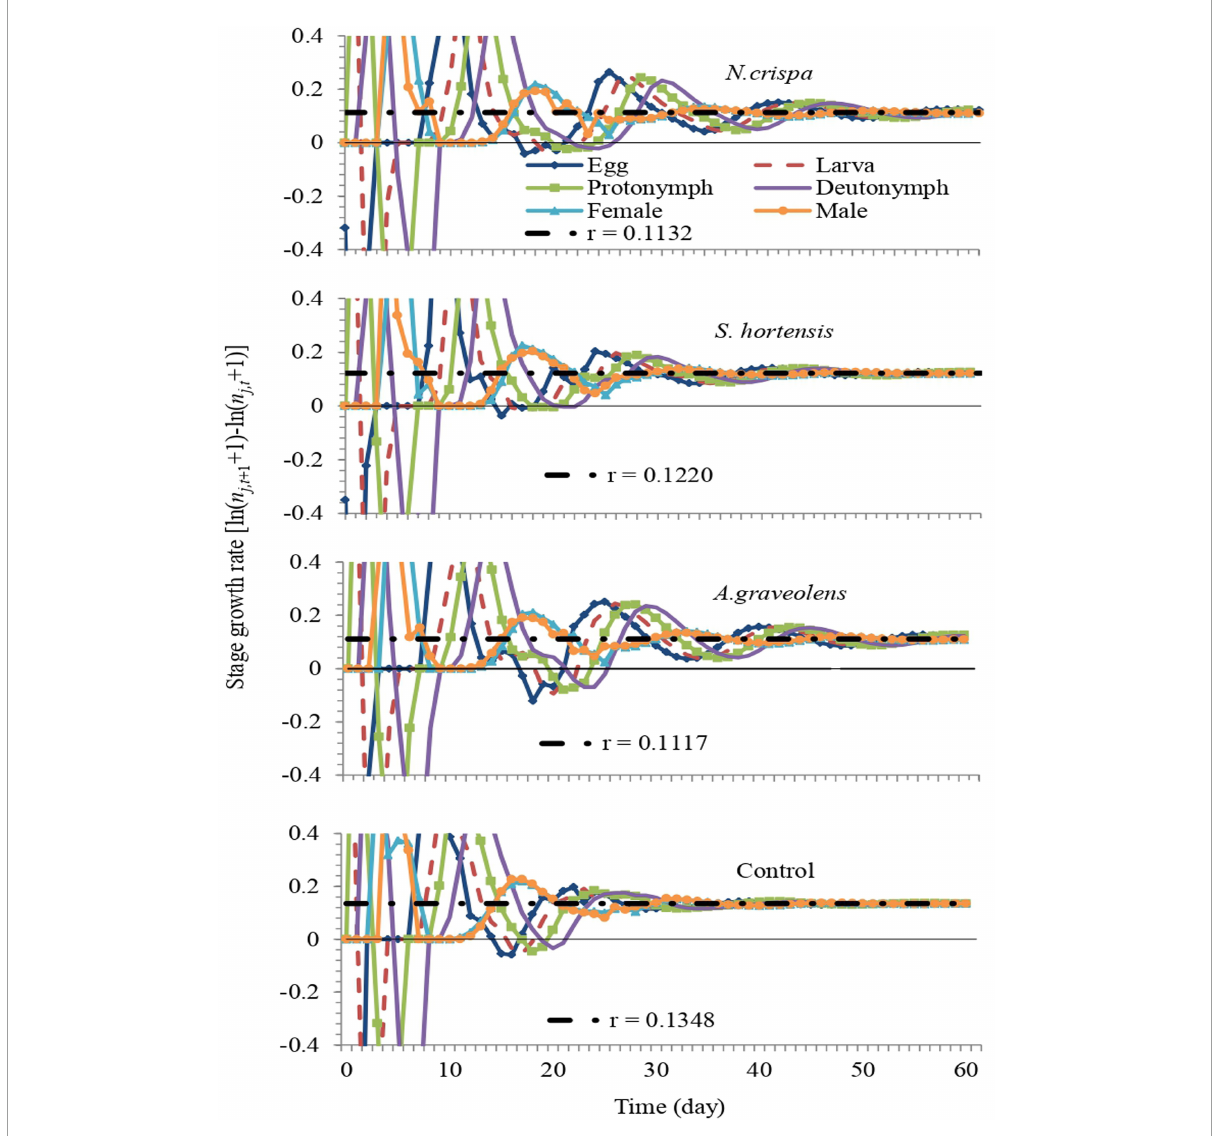
FIGURE8 Fluctuation of the growth rate of each life stage of A. swirskii from control and treatments of N. crispa , S. hortensis , and A. graveolens oils. We set the scale range of the y -axis from –0.4 to 0.4 to reveal the fluctuation of the growth rate around the intrinsic